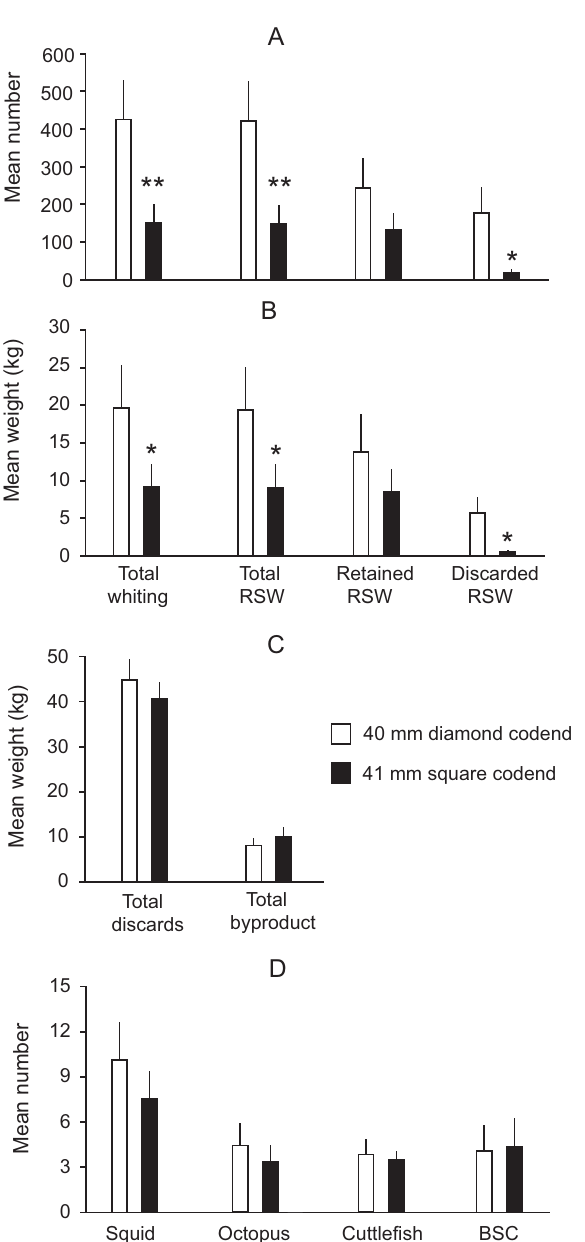
F IG . 7. – Differences in mean catch (+ se) per 60 min tow between the conventional 40 mm diamond codend and the 41 mm square codends, with and without the grid (same 45 mm trawl body), for the A) numbers and B) weights of red spot whiting categories, C) weights of total discards and byproduct, and D) numbers of key byproduct species. * P < 0.05, ** P < 0.01 (paired t